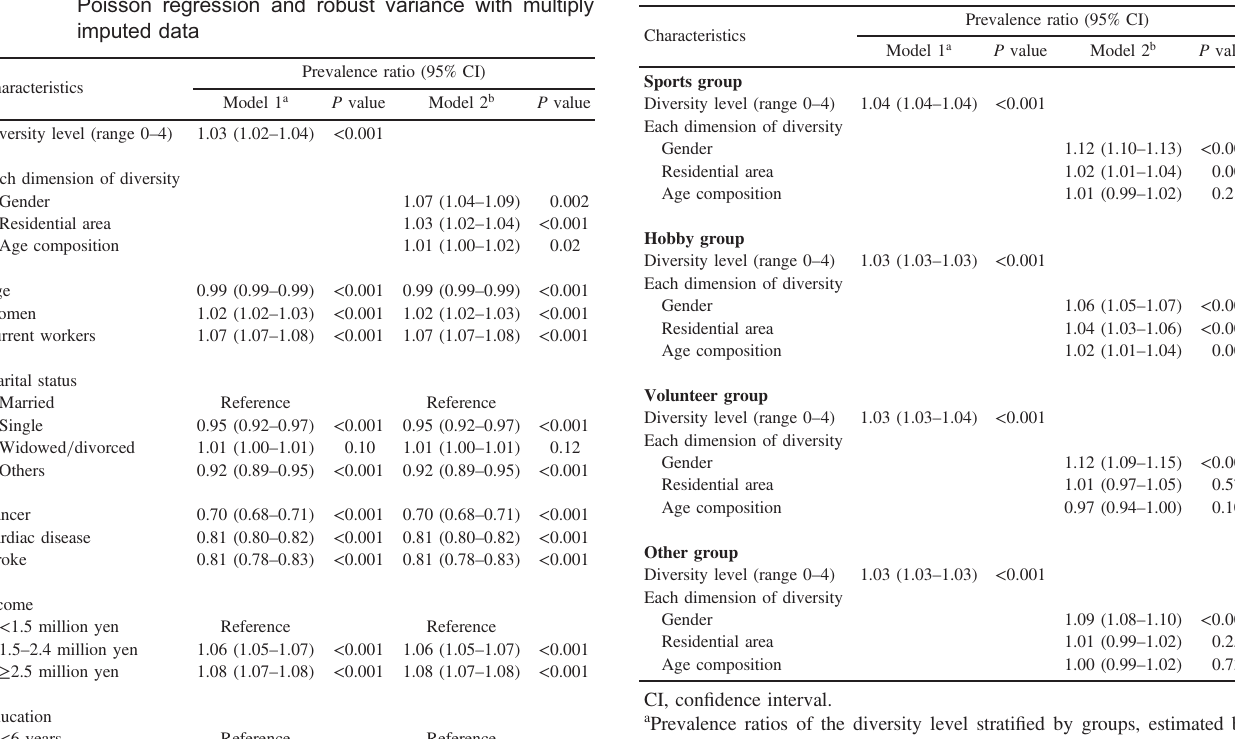
Table 3. Prevalence ratios and 95% con fi dence intervals for better self-rated health strati fi ed by